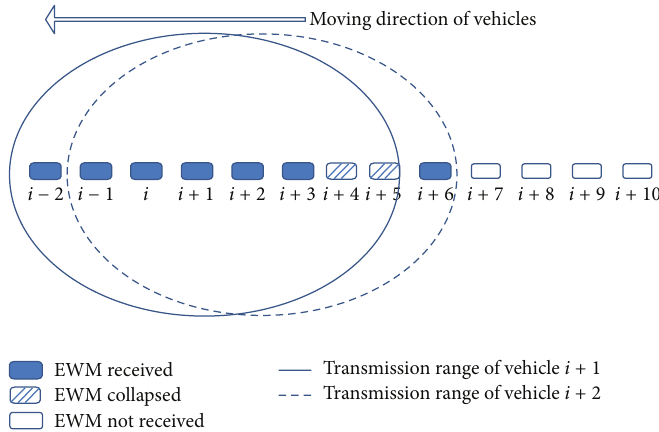
Figure 1: EWM collisions in the vehicle